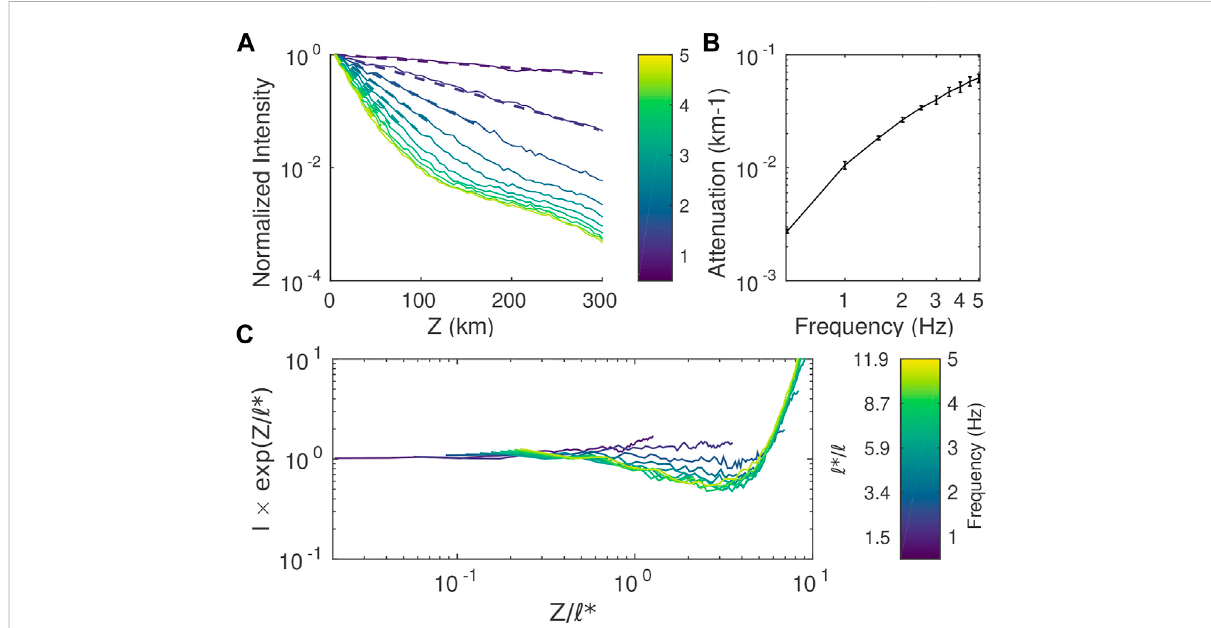
FIGURE 13 Measurement of peak intensity attenuation. (A) Peak intensity decrease with distance (solid lines) and the fi tted exponential regression (dashed lines), the colorbar represents different central frequencies ranging from 0.5 to 5 Hz with a frequency step of 0.5 Hz. (B) Peak intensity attenuation and bar errors. (C) dependence of scaled intensity I × exp ( z/ ℓ p ) versus z/ ℓ p . Case ] = 0.5 ε =